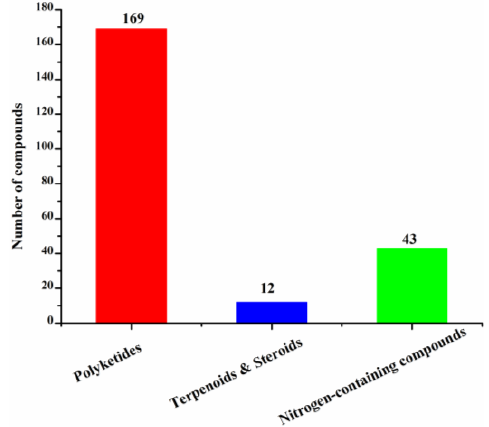
Figure 12. Structural classes of new halogenated compounds (1994–2019).